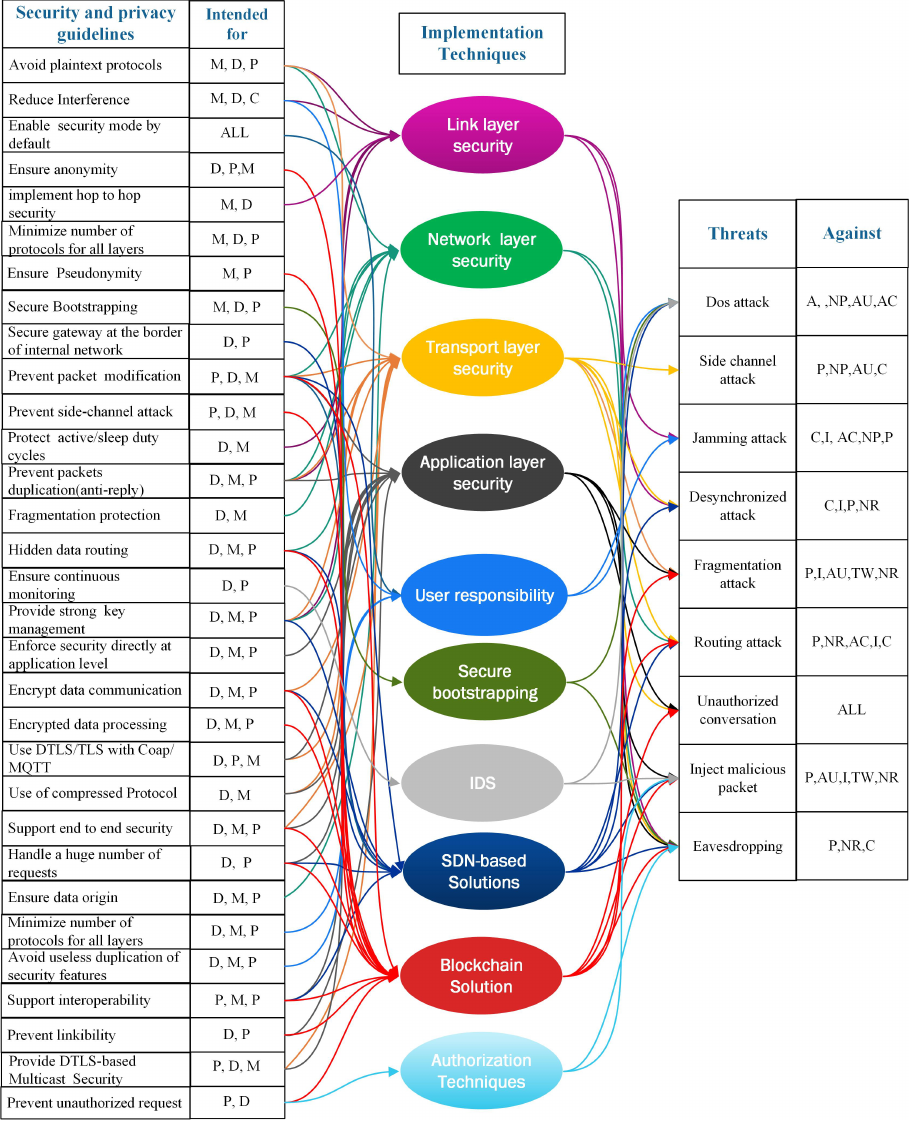
Figure 4. An overview of guidelines, stakeholders, attacks and countermeasures for communication level.